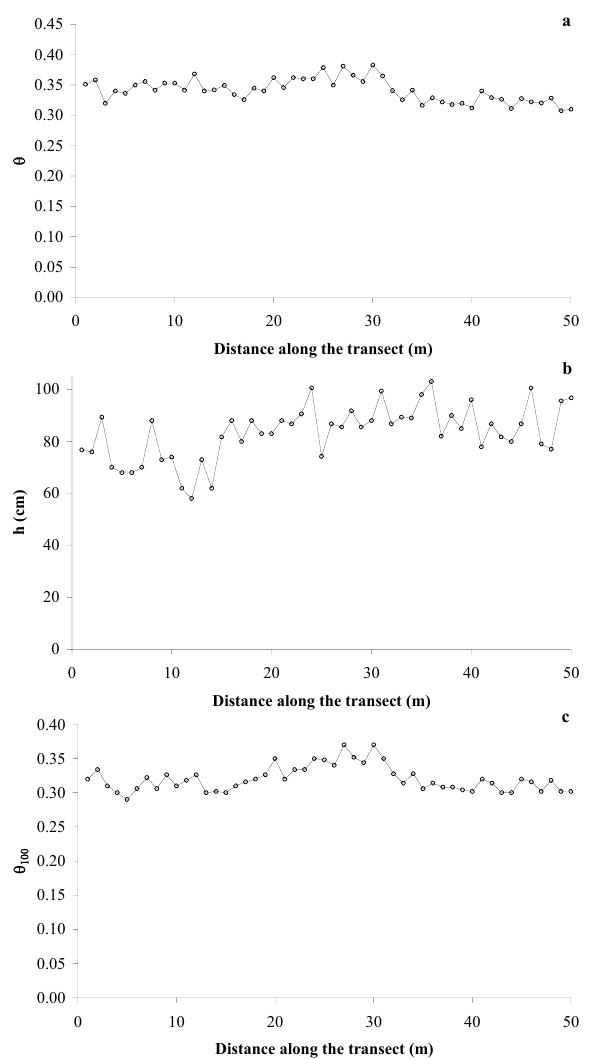
Fig. 5. Measured values of: (a) soil water content θ 3 , (b) soil water tension h 3 and (c) soil water content θ 100 , at h = 100cm.